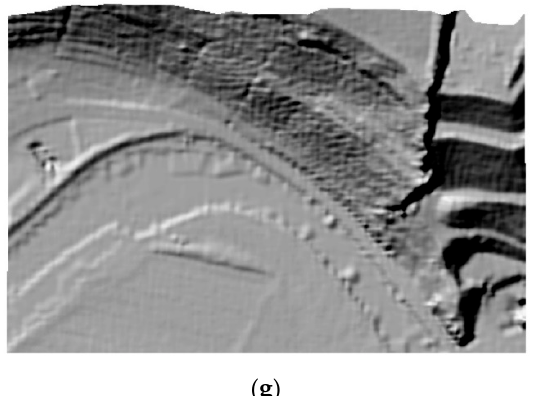
Figure 7. Shaded relief maps of the proposed methods and the other interpolations on s-52. ( a ) Linear; ( b ) natural neighbor (NN); ( c ) inverse distance weighting (IDW); ( d ) ordinary kriging (OK); ( e ) DCT-G (DCT-based TPS with the generalized cross-validation); ( f ) DCT-T (DCT-based TPS with the trial-and-error); ( g ) proposed.